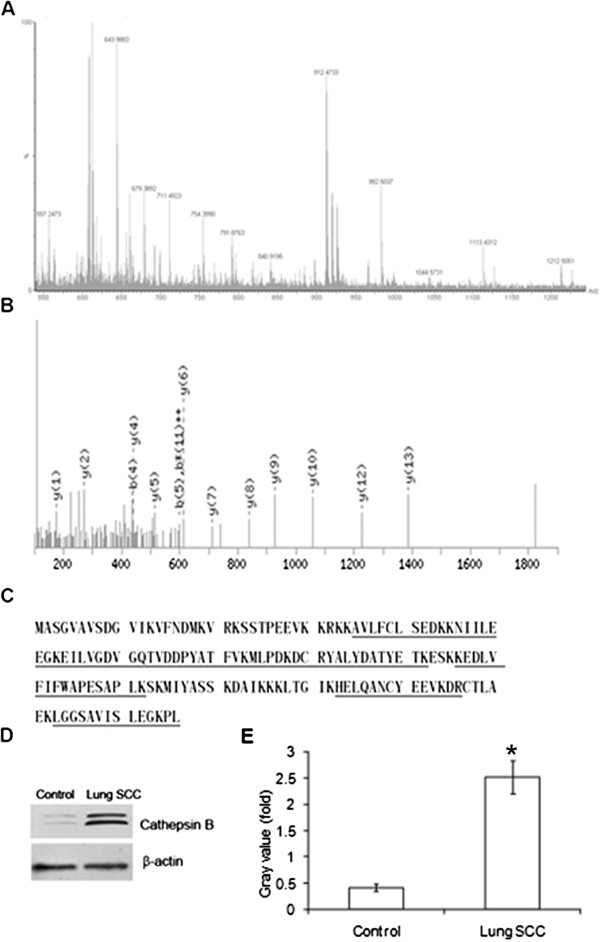
CTSB as the representative of protein identification using ESI-Q- TOF-MS/MS. (A &B) Mass spectrogram of tryptic peptides from spot #15. (C) Protein sequence of CTSB. The matched peptides are underlined. (D) Western blotting confirmation of the proteins CTSB, corresponding to the spot #15. As shown, expression of CTSB was up-regulated in lung SCC compared with adjacent normal tissues. The experiment was repeated three times. (E) The level of CTSB was 2.52 ± 0.31 in the lung SCC group, and 0.42 ± 0.07 in control (adjacent normal tissues) (P < 0.05). β-actin was used to normalize for any differences in protein loading between lanes.